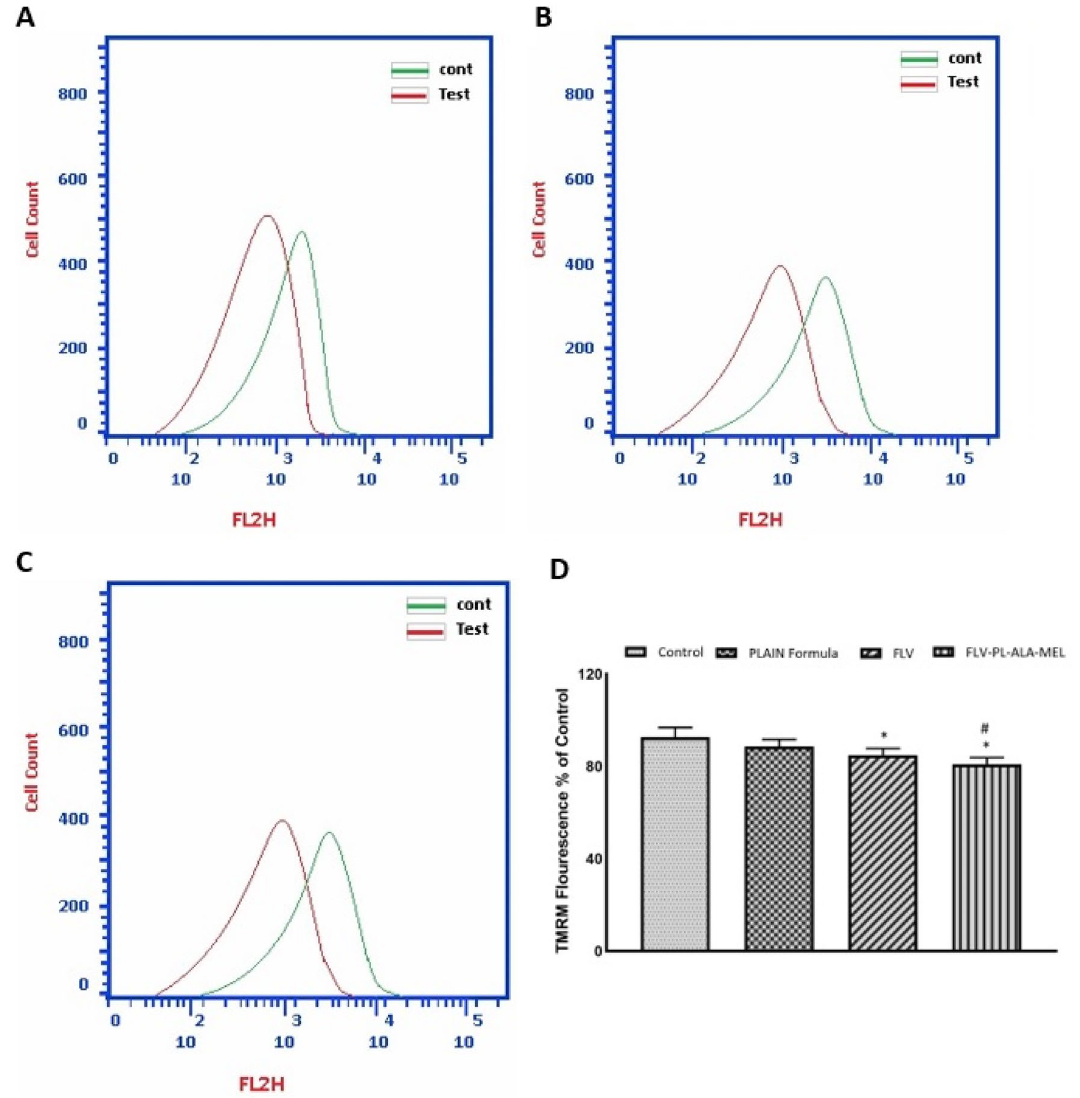
Figure 11. The effect of optimized FLV-PL-ALA MEL on Caco2 cells’ MMP variation. Normationalization of values took place with respect to untreated (control) Caco2 cells and expressed as variation percentage. Data denote the mean of four independent experiments ± SD. To make several comparisons, we used the Tukey post hoc test. *Significantly different versus control (p < 0.05). # Significantly different versus Plain formula (p <